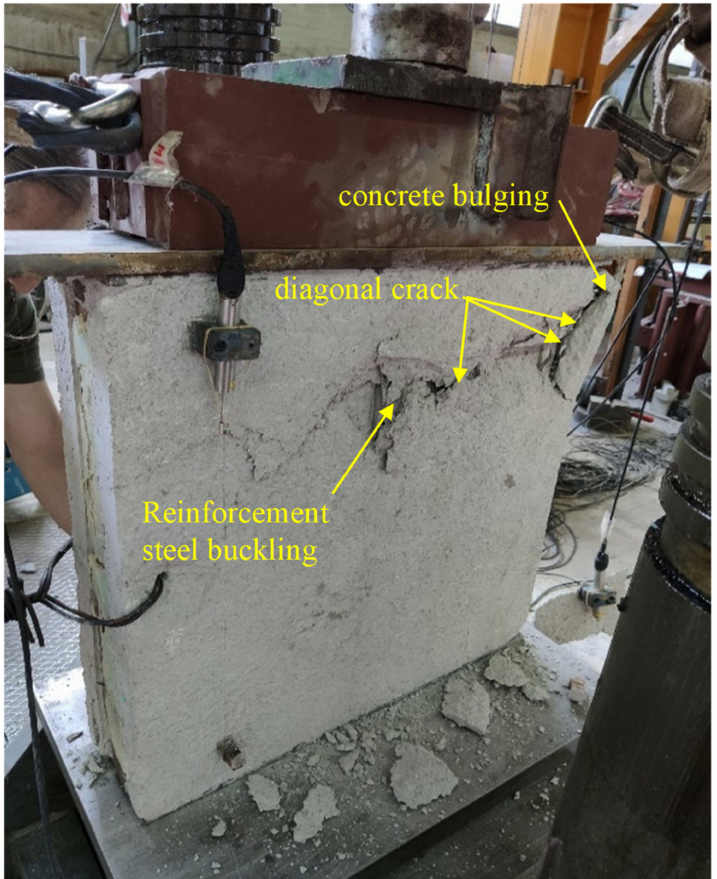
Figure 8. Failure mechanism of PCSP-2a specimen under concentric axial